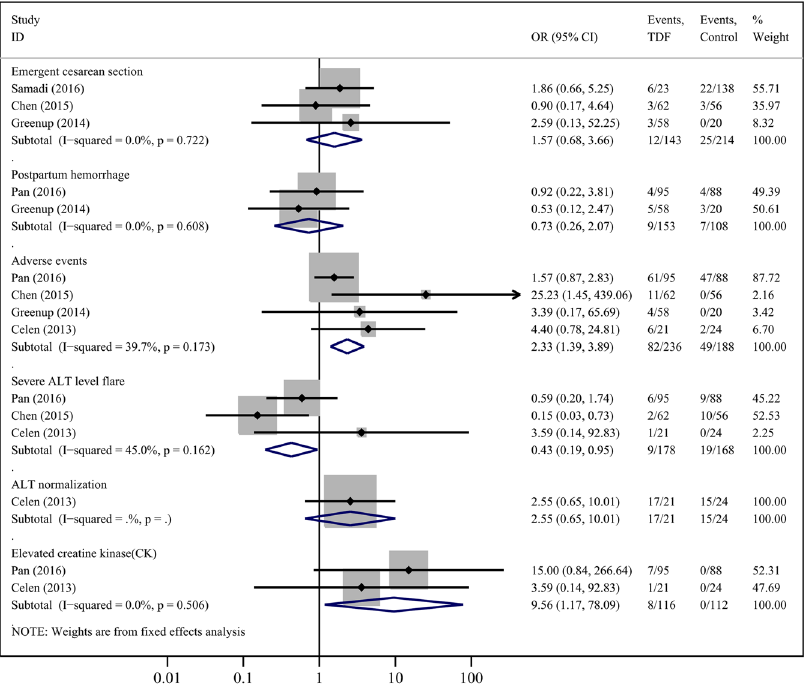
Figure 3. Forest plot showing meta-analysis of maternal outcomes for studies comparing TDF versus control at delivery, based upon fixed-effects